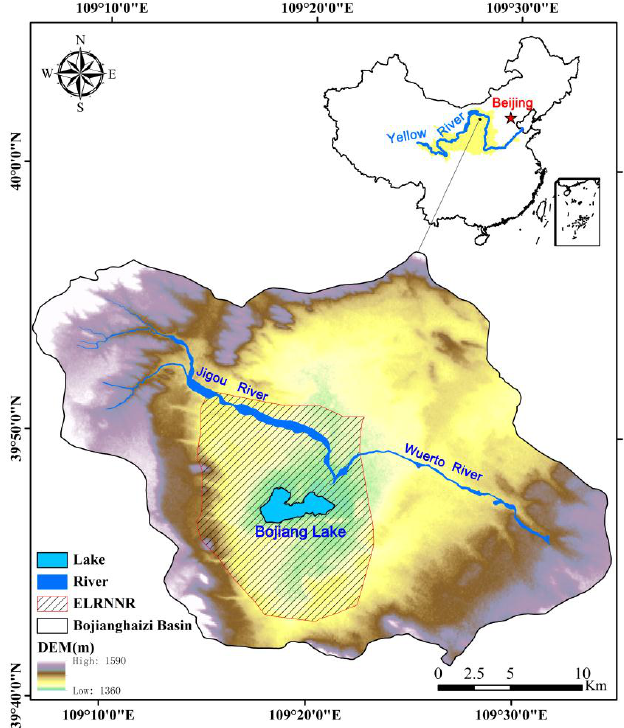
Figure 1. Location of the Erdos Larus relictus National Nature Reserve (ELRNNR).